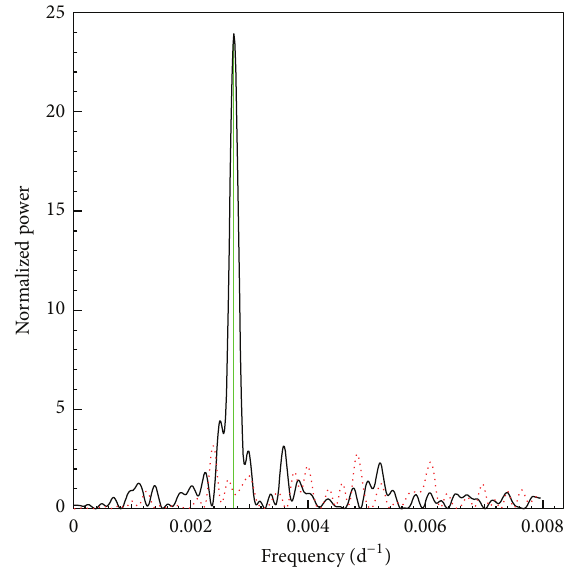
Figure 2: Power spectrum of the measured single-hit residuals in the (2–6) keV (solid lines) and (6–14)keV (dotted lines) energy intervals calculated according to [8], including also—as usual in DAMA analyses—the treatment of the experimental errors and of the time binning. The data refer to DAMA/NaI and DAMA/LIBRA- phase1. As it can be seen, the principal mode present in the (2– 6) keV energy interval corresponds to a frequency of 2.737×10 −3 d −1 (vertical lines), corresponding to a period of ≃ 1 year. A similar peak is not present in the (6–14)keV energy